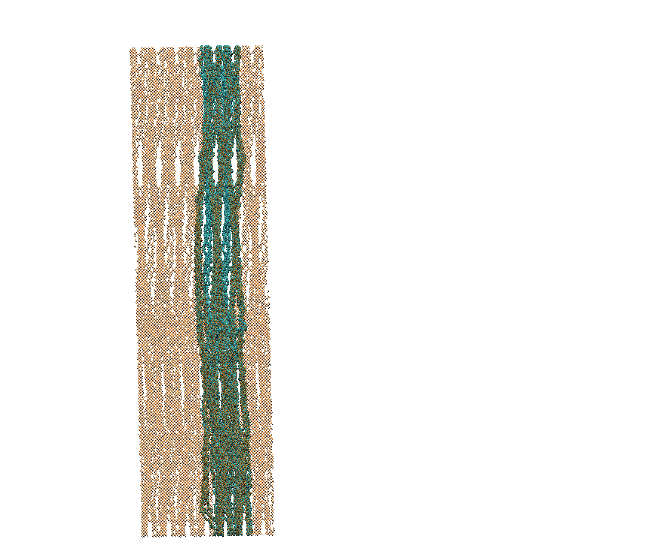
Figure A4. CLG Fiber (blue):a two-by-two replication of CLG NanoFiber, seen among the seven-by- seven periodic replication of the CLG Fibril’s UC (orange transparent). View of xz-plane ( left ) and yz-plane ( right ) in VMD.